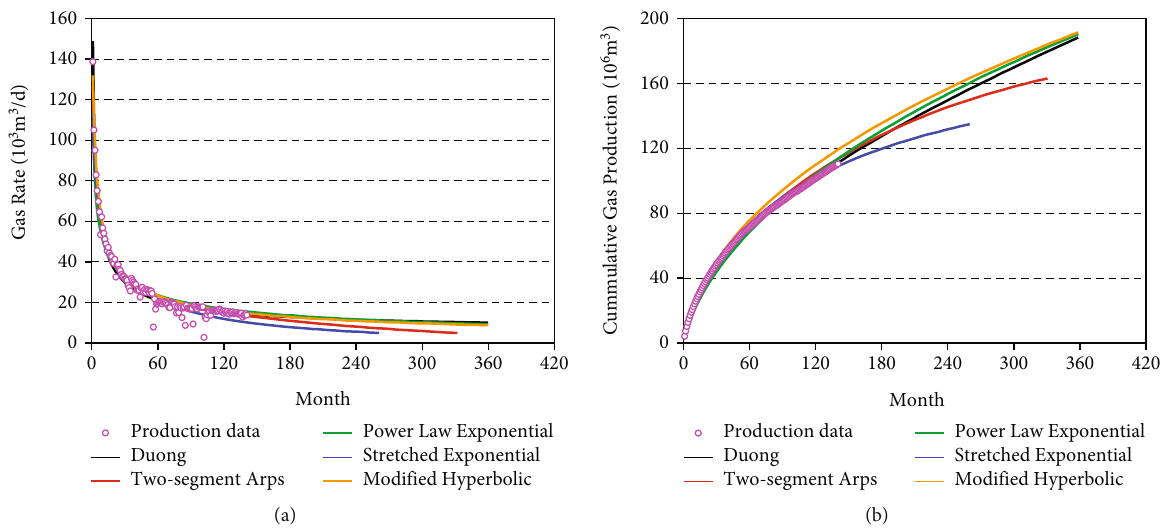
Figure 6: Comparison of fi ve di ff erent DCA methods on a typical horizontal well in Montney: (a) gas rate vs. time; (b) cumulative gas production vs.